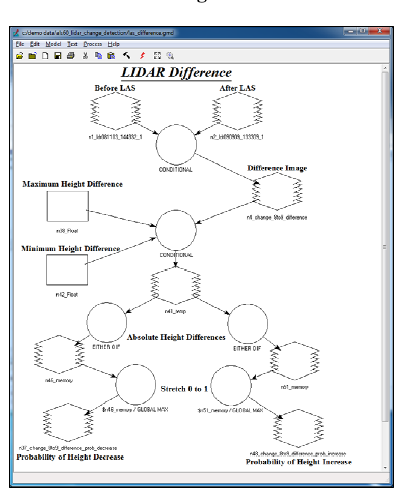
Figure 2.The graphical model used to produce Probability of Height increase and Probability of Height Decrease images.